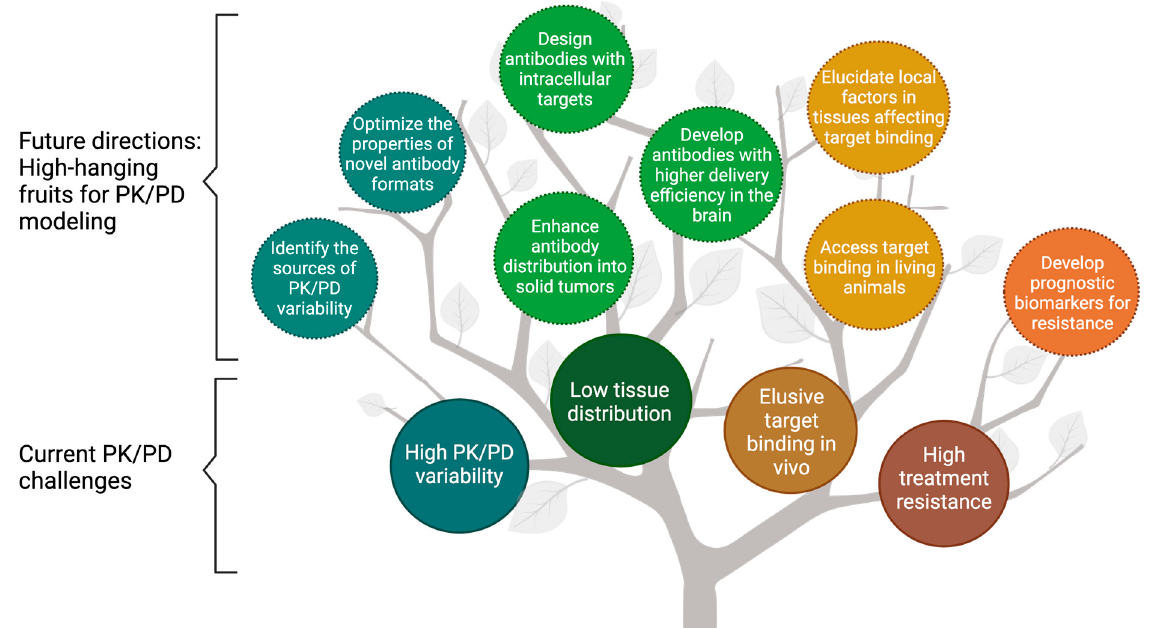
Figure 1. The fruit tree model presents the current challenges and future directions for modeling the pharmacokinet- ics/pharmacodynamics (PK/PD) of therapeutic antibodies. PK/PD modeling has been widely used to overcome the chal- lenges associated with antibodies, including high PK/PD variability, low tissue distribution, elusive target binding in vivo, and high treatment resistance (enclosed in solid lines). This review discussed the future directions for PK/PD modeling in antibody development, namely the “high-hanging fruits” for PK/PD modeling (enclosed in dash lines). PK = Pharmacoki- netics; PD = pharmacodynamics.